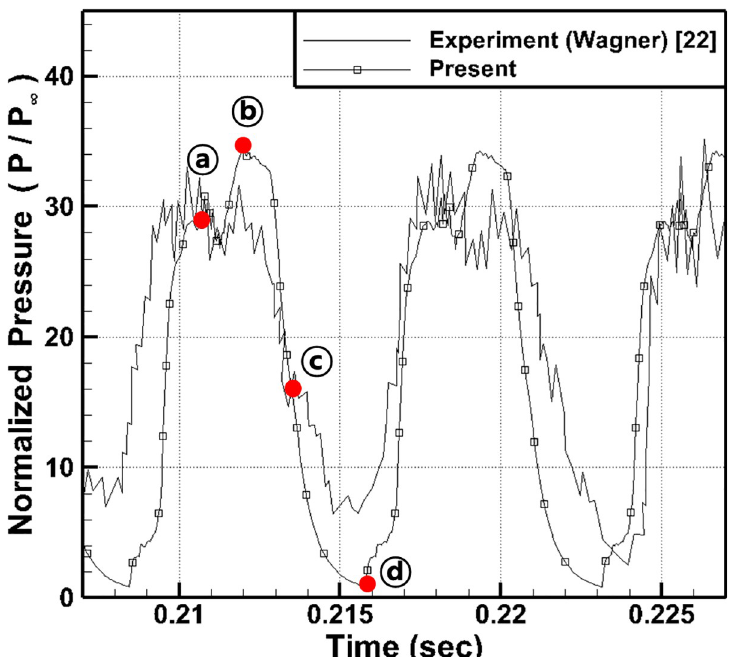
Fig 10. Comparison of pressure time history at x/h = 12.21 with experimental data.